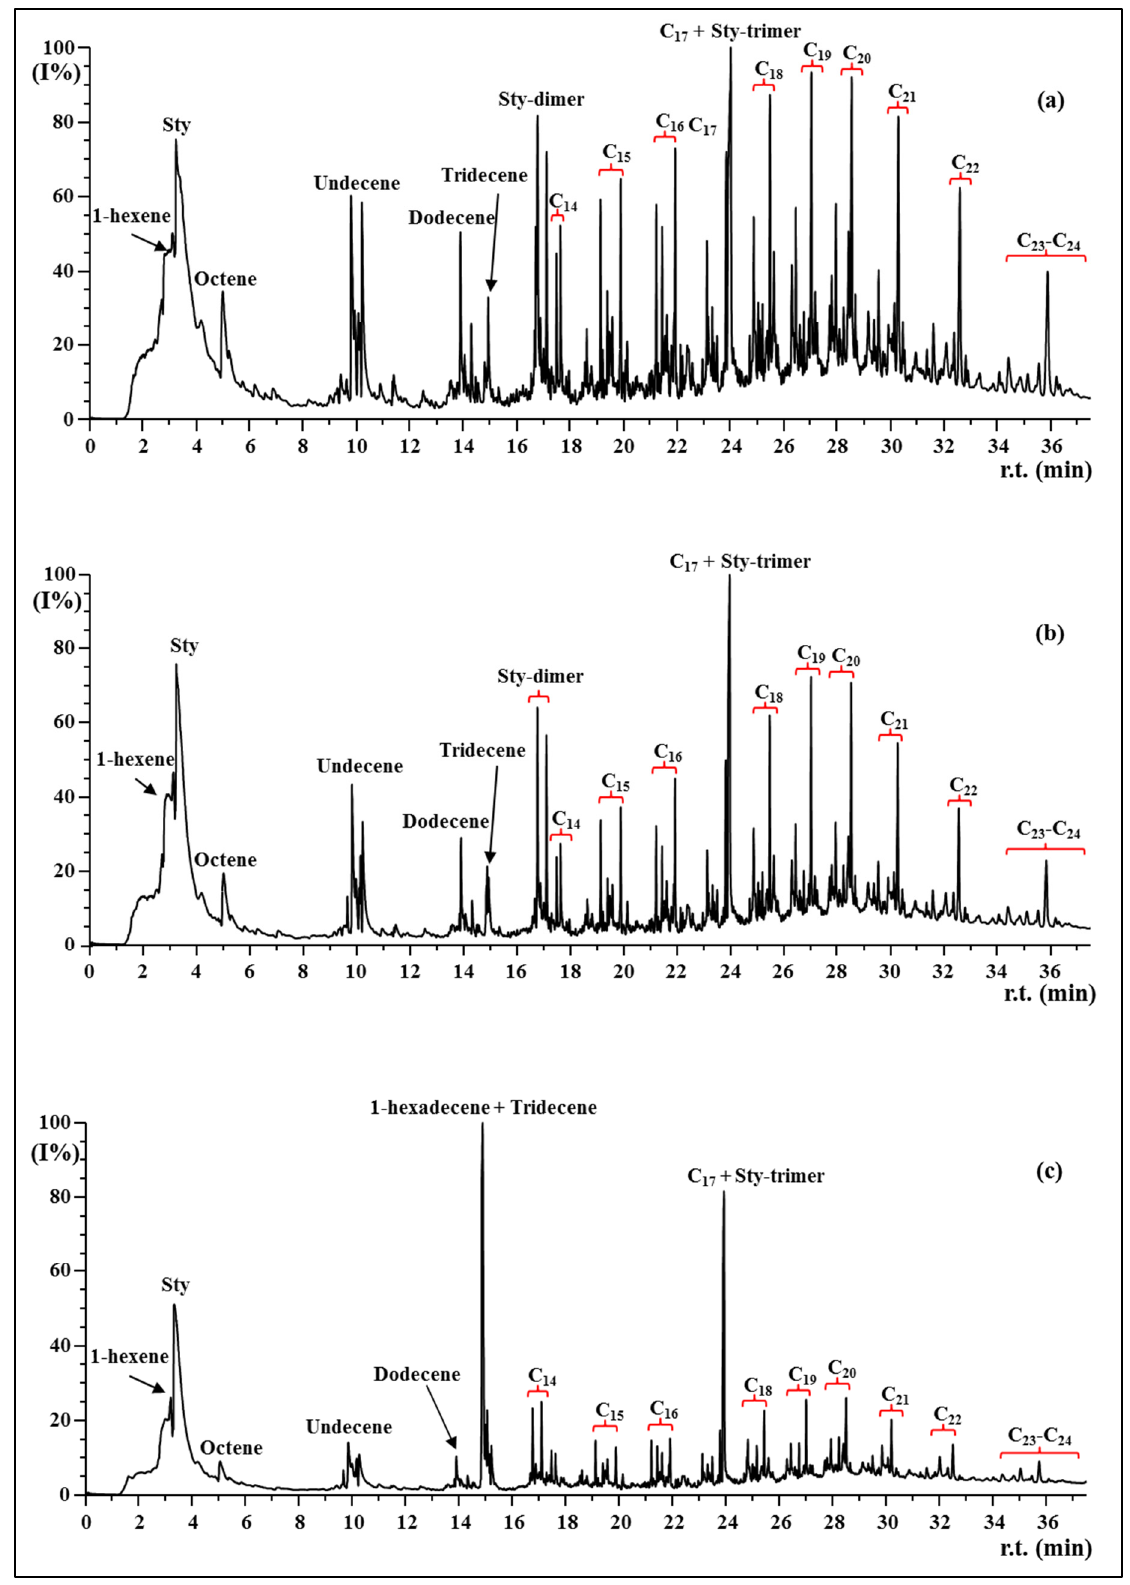
Figure 12. Py-GCMS pyrograms of the pyrolysis products of neat SEBS ( a ), SEBS/1% HdmimDMSIP, ( b ) and SEBS/10% HdmimDMSIP ( c ) at 450 °C.